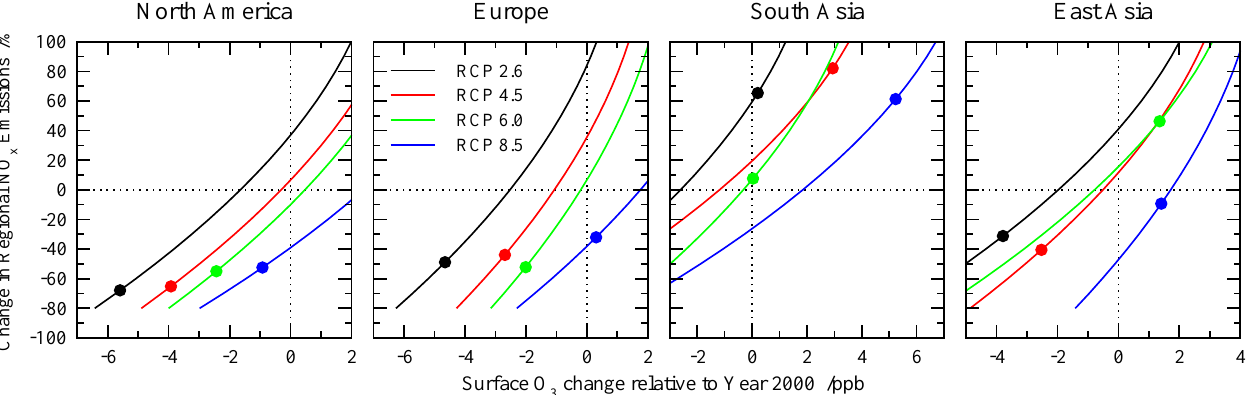
Fig. 12. Sensitivity of regional surface O 3 in 2050 to regional NO x emissions under each of the RCP scenarios. Circles mark the ensemble mean surface O 3 response under each scenario, and curves show how this would change for different regional NO x emissions. Dashed lines mark year 2000